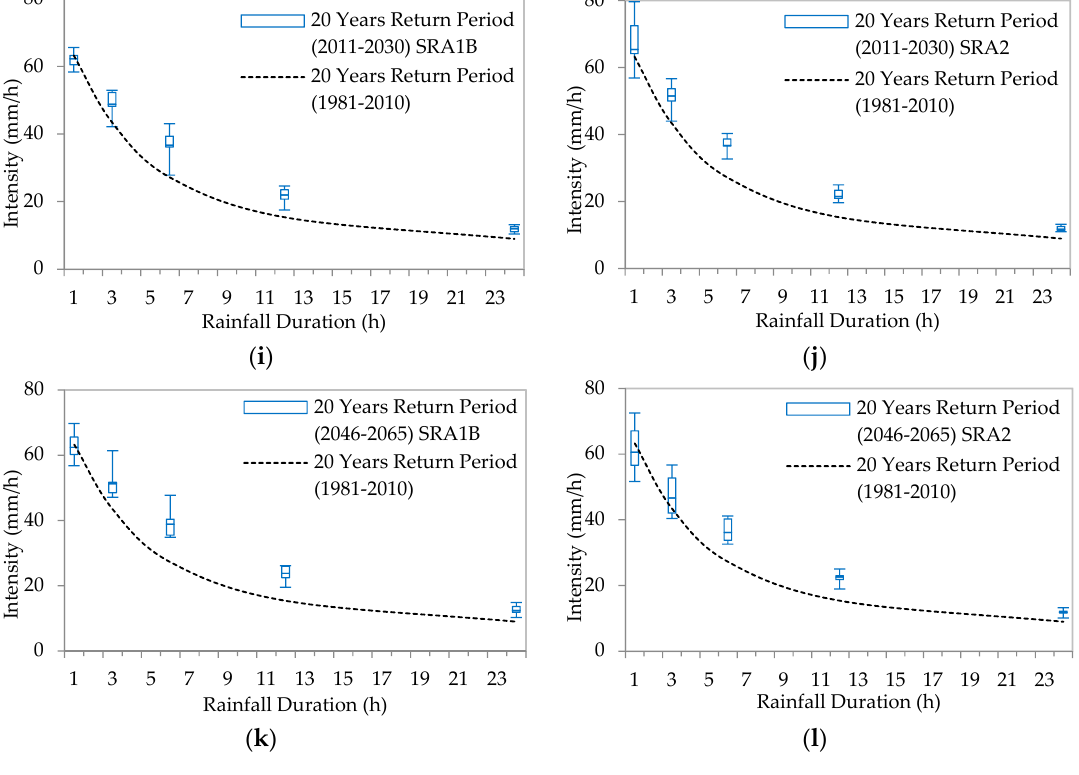
Figure 8. Results in box and whiskers plot from nine GCMs’ derived IDF curves for 2-, 5- and 20-years return periods: for the SRA1B scenario ( a , c , e , g , i , k ); and for the SRA2 scenario ( b , d , f , h , j , l ) for future